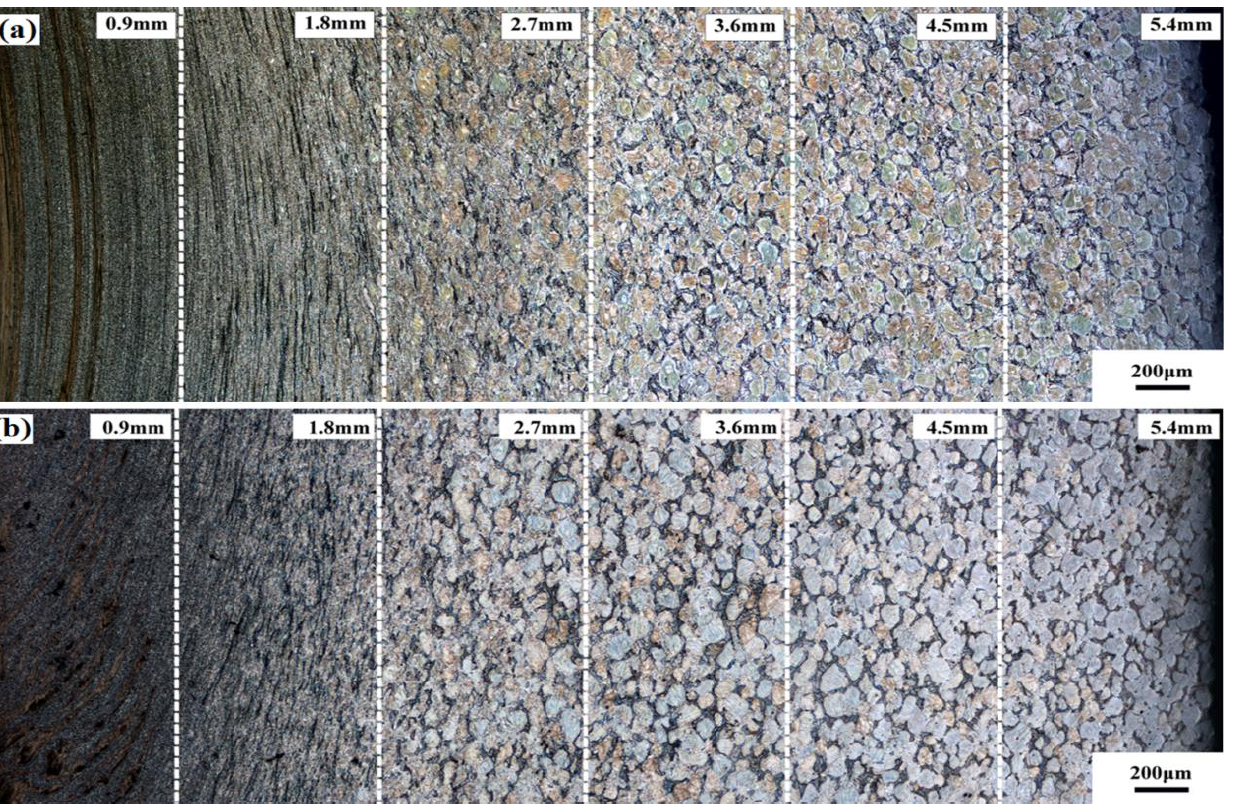
Figure 3. ( a ) The OM images of the cross-section in the different zones along the radial direction (RD), ( b ) the microstructure of the vertical section in the different zone profiles along the extrusion direction (ED) of the RBEed sample after 100 N.